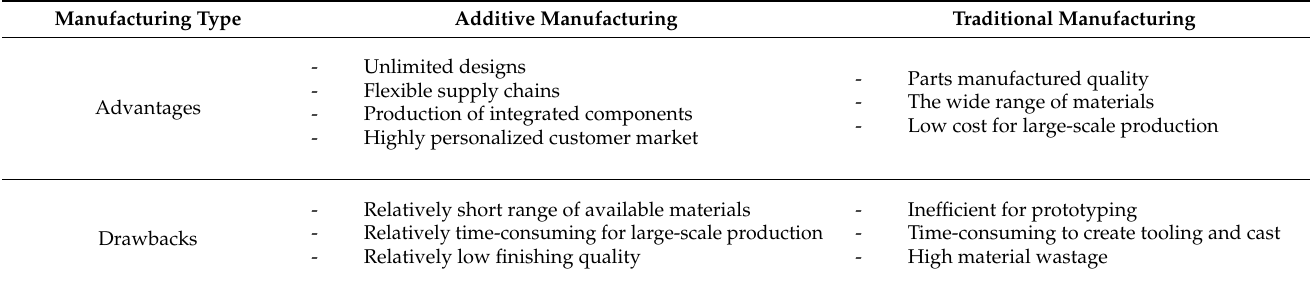
Table 2. Additive and conventional manufacturing attributes.